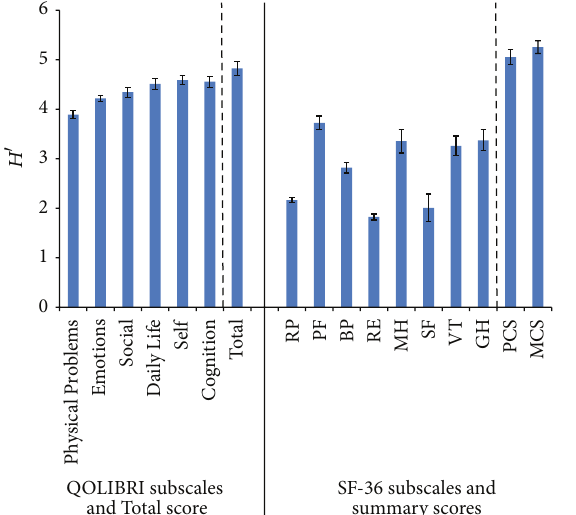
Figure 1: Shannon indices 𝐻 󸀠 (confidence intervals 95%) of all QOLIBRI and SF-36 subscales, QOLIBRI Total score and summary scores.